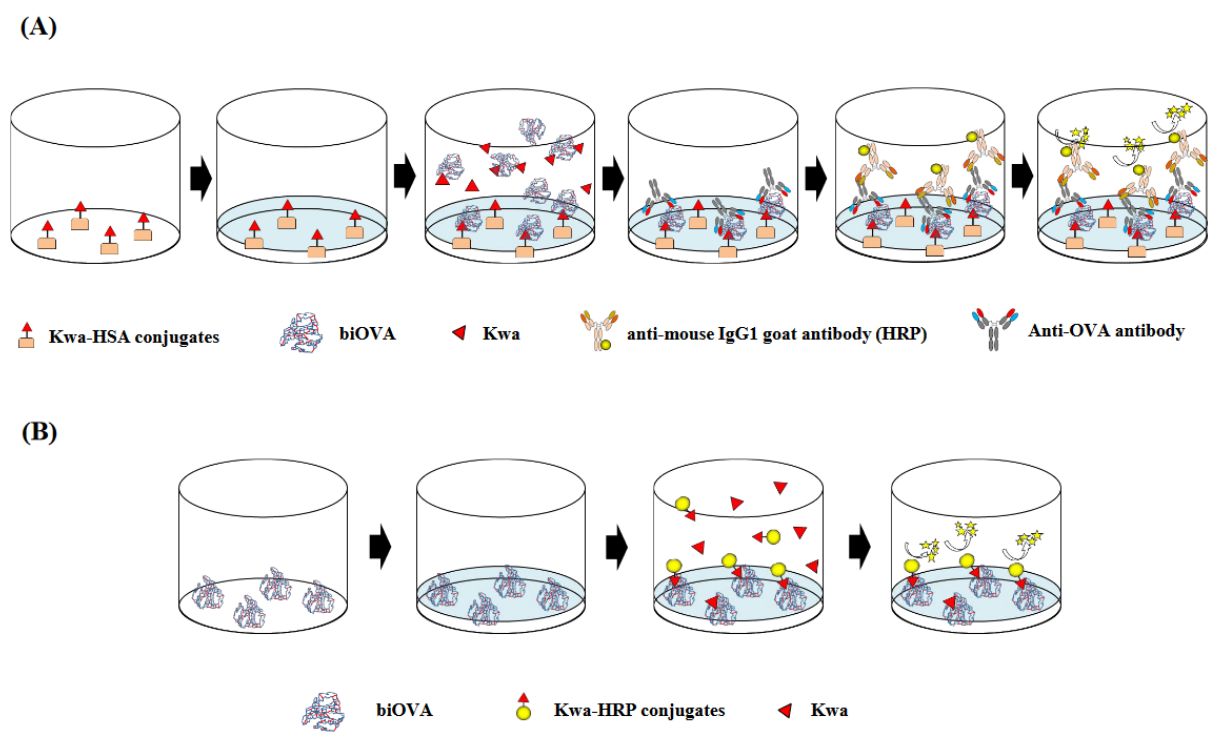
Figure 2. Schematic diagrams of ( A ) the icELISA and ( B ) cELBIA using biOVA. ( A ) The biOVA competitively reacted with the free Kwa or Kwa on the Kwa-HSA conjugates and biOVA binding to Kwa-HSA conjugates were continuously detected by anti-OVA antibody and HRP-labeled anti-mouse IgG1 goat antibody. ( B ) The free Kwa and Kwa-HRP conjugates competitively reacted to the immobilized biOVA. Binding of the Kwa-HRP conjugates to biOVA was detected.